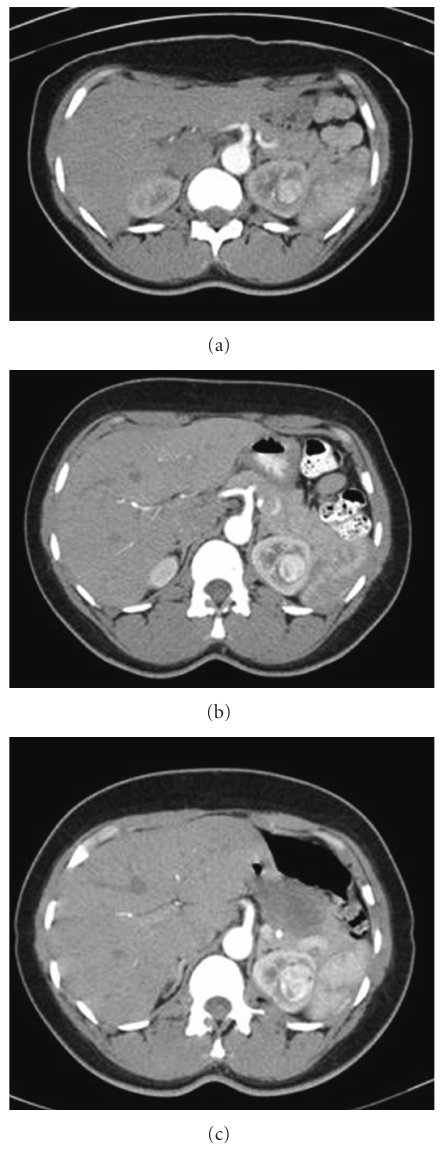
Figure 1: Serial contrasted CT scan of the abdomen demonstrating interval growth of enhancing left renal mass (12, 8, 4 months prior to partial